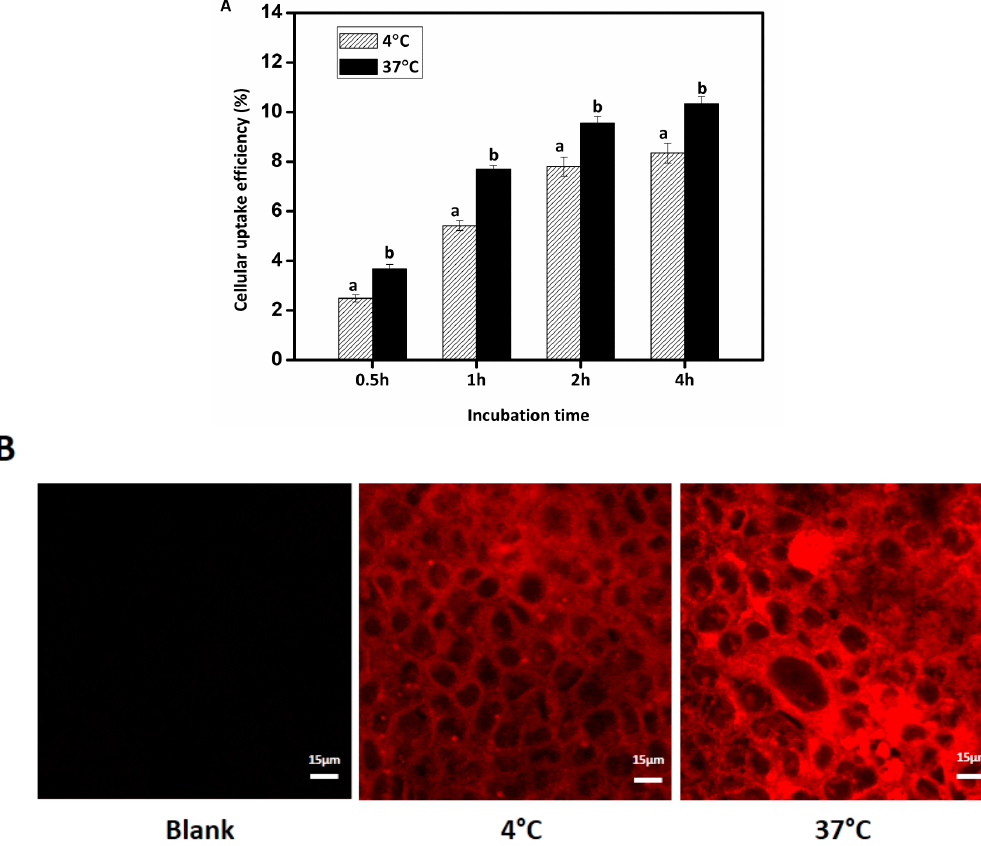
Figure 8. Cellular uptake efficiency ( A ) of lipid-based nanoemulsions at different intervals (0.5, 1, 2, and 4 h) at 4 and 37 °C; CLSM ( B ) of Caco-2 cells after cellular uptake of lipid-based nanoemulsions for 4 h at 4 and 37 °C, respectively. All data were analyzed using ANOVA (Values with different letters at the same time point are significant differences). Scale bar indicates 15 μ m. The data were expressed as mean ± standard with three independent replicates.